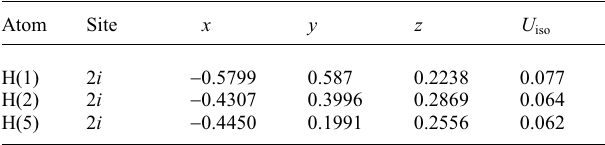
Table 2. Atomic coordinates and displacement parameters (in Å 2 )